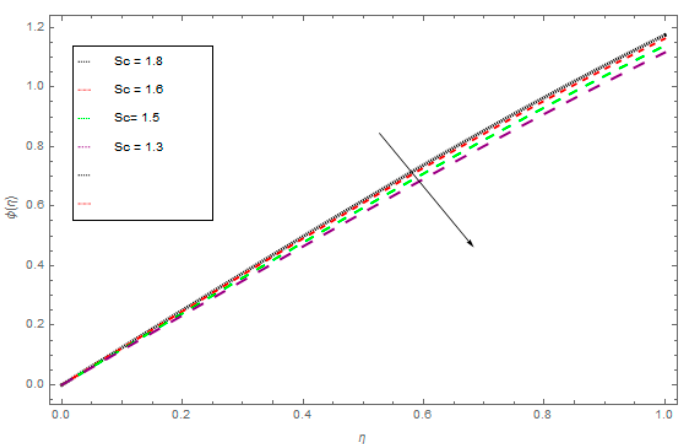
Figure 9. The influence of Nt on ϕ ( η ) when Nb = 0.6, Sc = 0.7, S = 0.7.